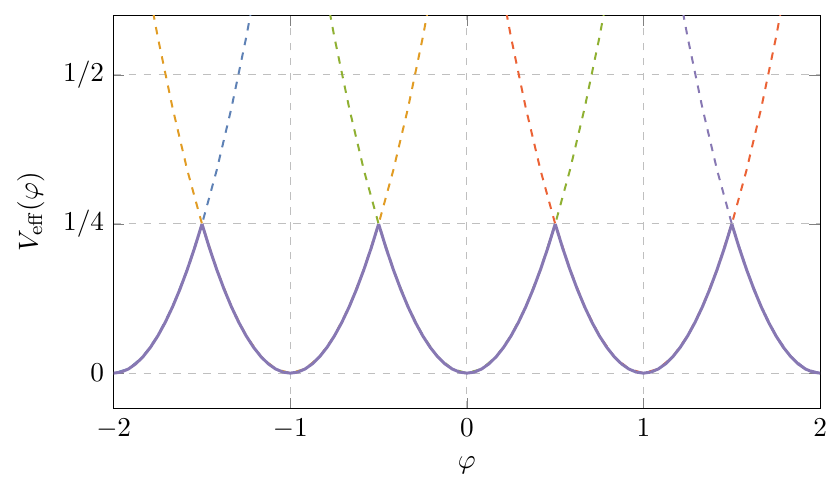
Figure 3. The gapless, \monodromy-like," e(cid:11)ective potential (solid, in units of (2 (cid:25) ~ g ) 2 = 2), is the minimum of multiple quadratic branches (dashed). The e(cid:11)ective potential predicts that the axion will execute simple harmonic motion for small energies, while for high energies it will wind around the axion’s compact (cid:12)eld space